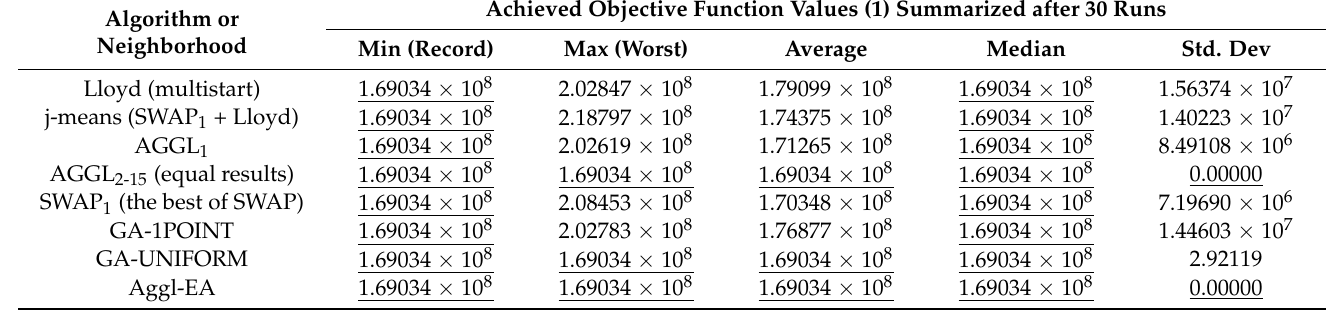
Table A4. Comparative results for S1 dataset. 5000 data vectors in R 2 , p = 15 centers, time limitation 1 s. Algorithm or